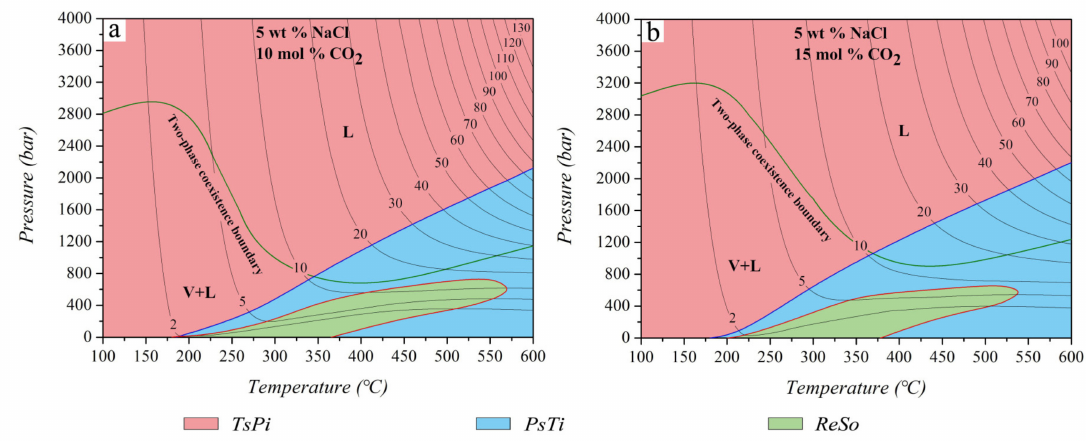
Figure 9. P-T diagram showing the single phase (liquid) and two-phase (vapor + liquid) field of H 2 O-NaCl-CO 2 ternary system, containing 10 mol% CO 2 ( a ) and 15 mol% CO 2 ( b ), contoured with quartz solubility isopleths. Three regions exhibiting di ff erent dependence on P and T are estimated (TsPi: temperature sensitive pressure inert; PsTi, and ReSo). For a fixed composition, if (T 0 , P 0 ) is any point on the curve of Equation (1), the boundary between TsPi and PsTi (the blue curve) is the locus of = ( ∂ m / ∂ P ) points of isopleths that have ( ∂ m / ∂ T ) P = P T = T 0 ; the boundary between PsTi and ReSo (the 0 red curve) is the locus of points of isopleths that have a slope of